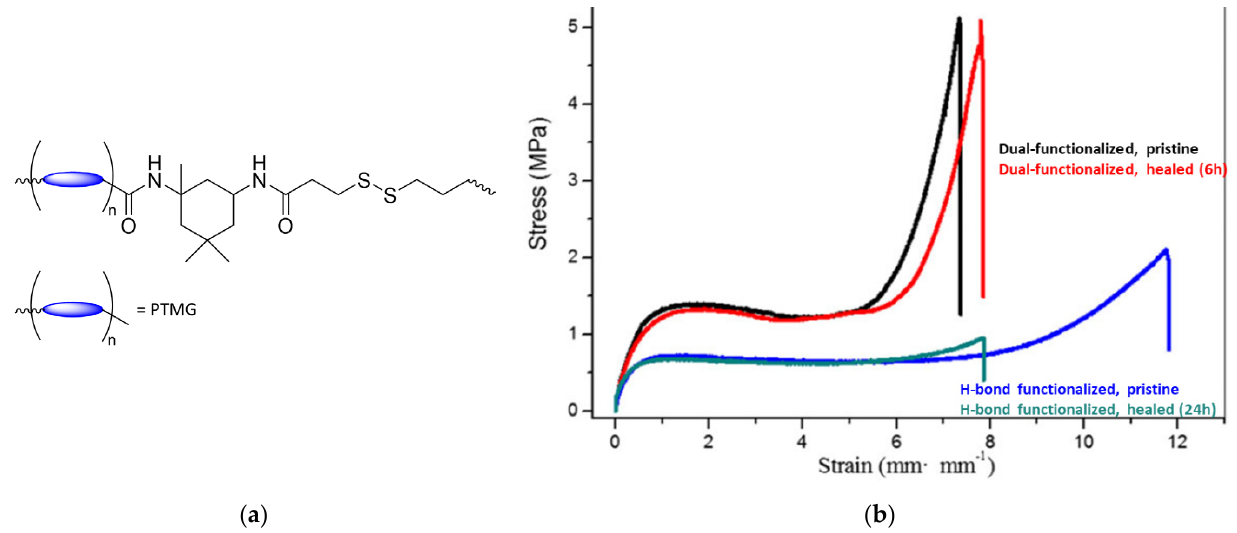
Figure 34. ( a ) Structure of dual-functionalized polyurethanes incorporating poly(tetramethylene ether) glycol (PTMG). ( b ) Tensile stress versus strain curves before and after self-healing for dual-functionalized PU and a control material with only hydrogen bonding Adapted with permission from [143]. Copyright (2017) Wiley Periodicals, Inc.